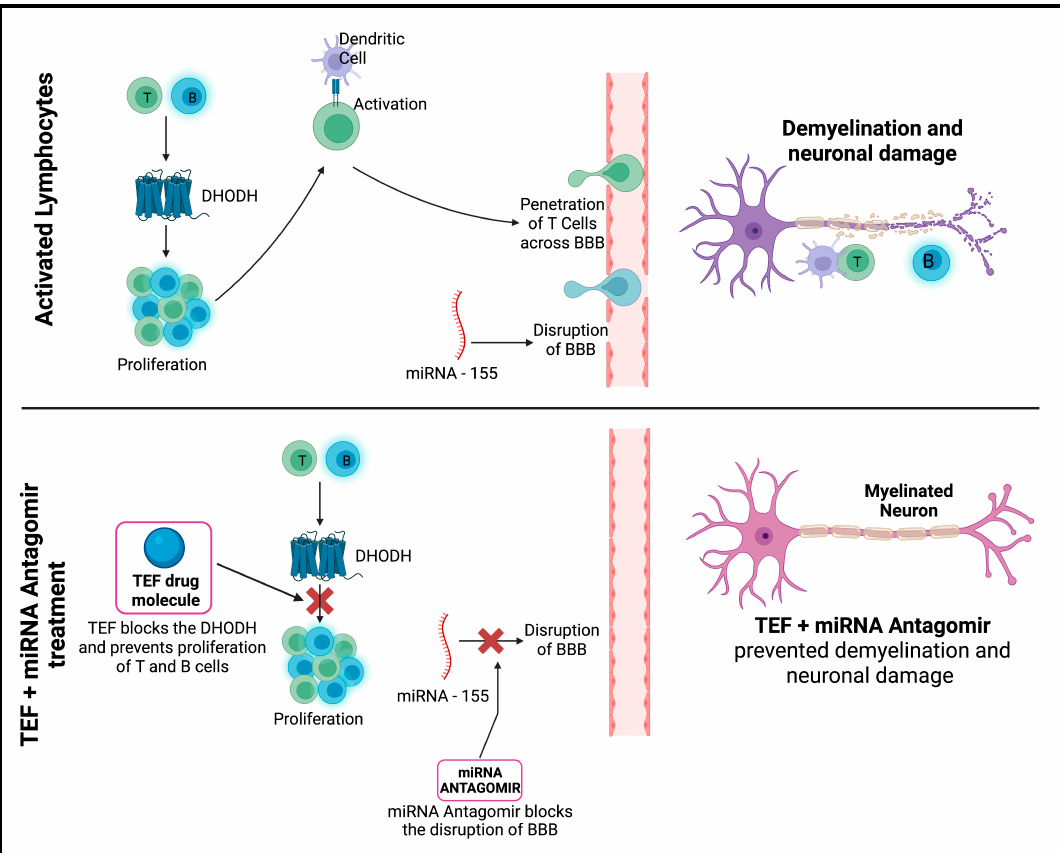
Figure 12. Schematic diagram demonstrating the underlying mechanism highlighting the conclu- sive evidence of the study. evidence of the